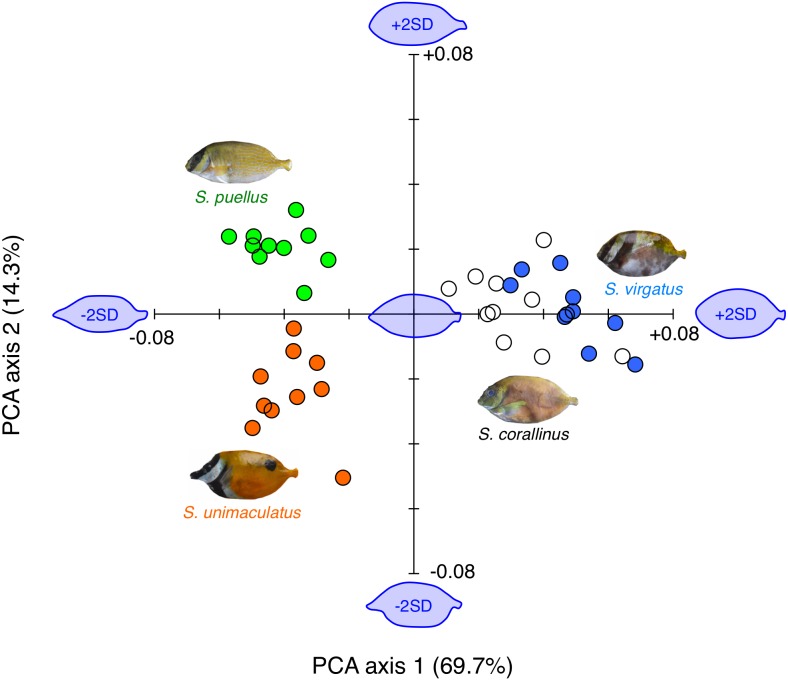
Results of the principal component analysis (PCA) of body shape variations among the four rabbitfish species.The estimated fish body shapes that were constructed using the Fourier coefficients [−2 standard deviations (SD), mean, and +2 SD] are also shown along PCA axes 1 and 2 (blue fish images). Orange circles: Siganus unimaculatus (n = 10); green circles: S. puellus (n = 10); white circles: S. corallinus (n = 10); blue circles: S. virgatus (n = 10).